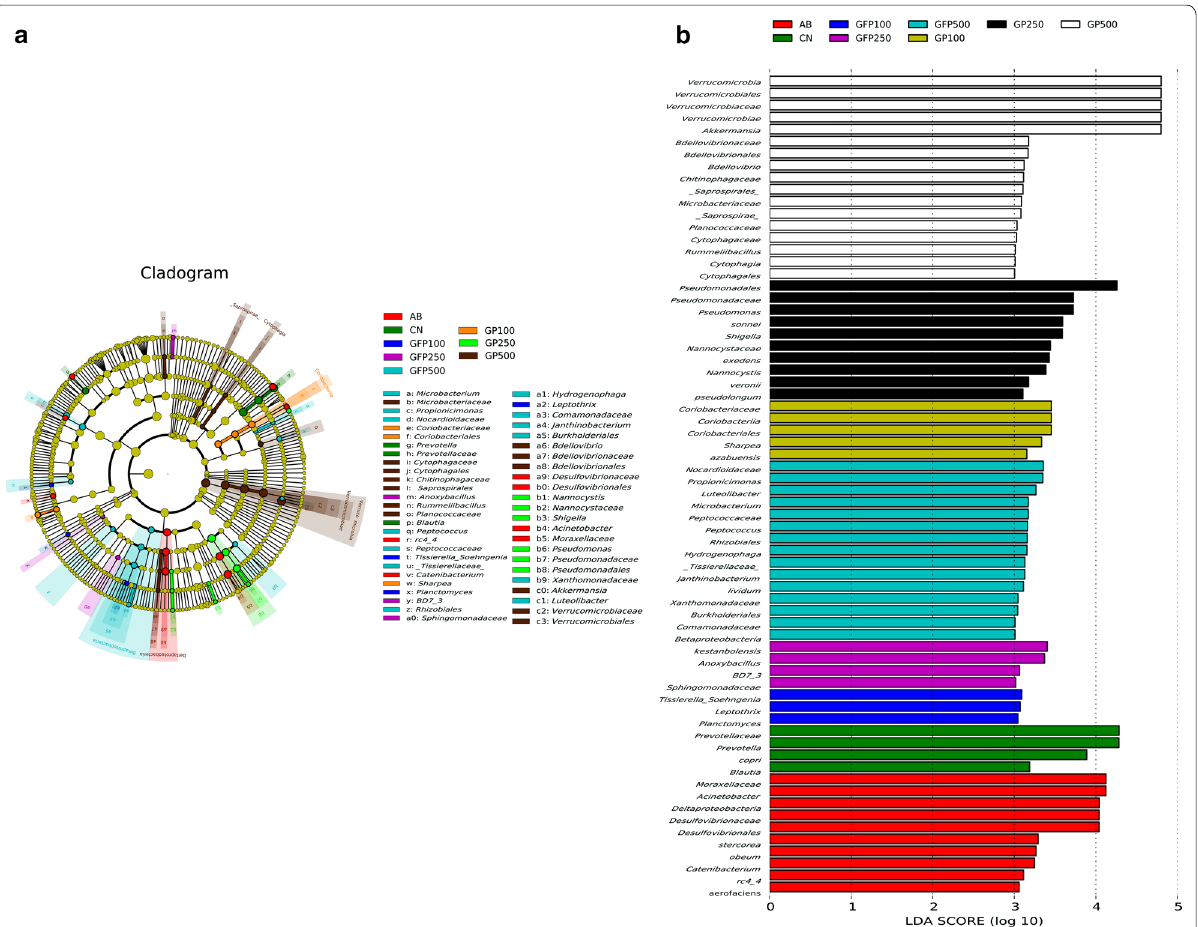
Fig. 4 LEfSe analysis filtered out the biomarkers of the microbial community after supplementation with different doses of XOS in pigs at different stages of development. a Cladogram plot of LEfSe analysis. b Histogram of LDA